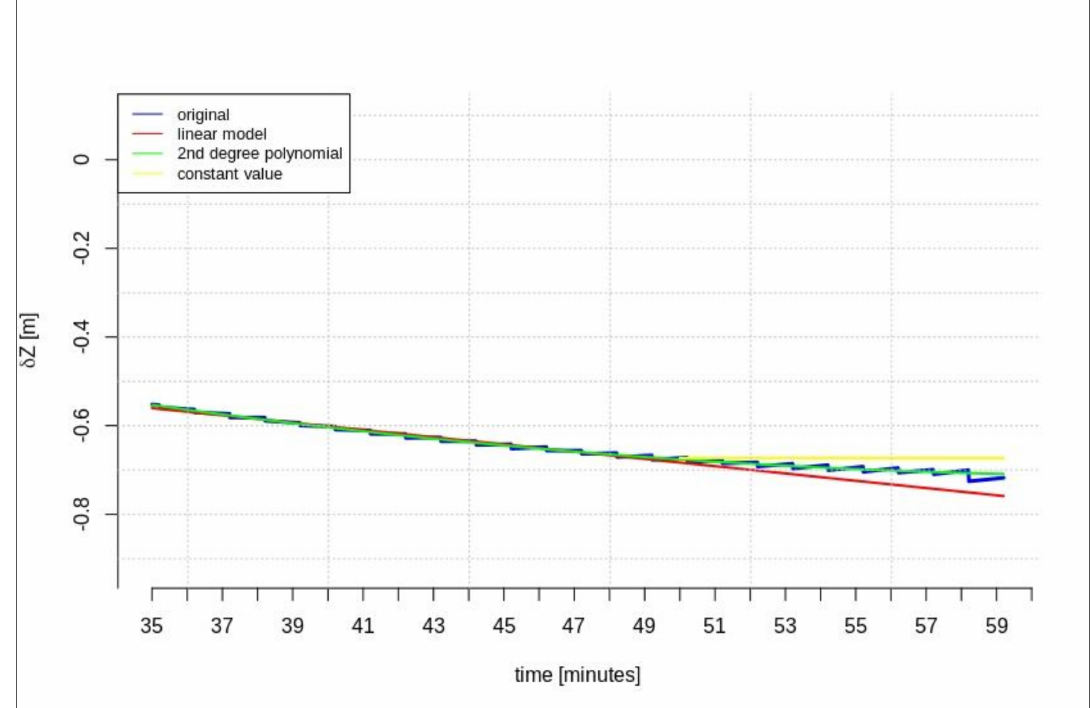
Figure 16. The results of the δ Z geocentric correction extrapolation (GPS G28) for a 15-min data-stream between each IODE.